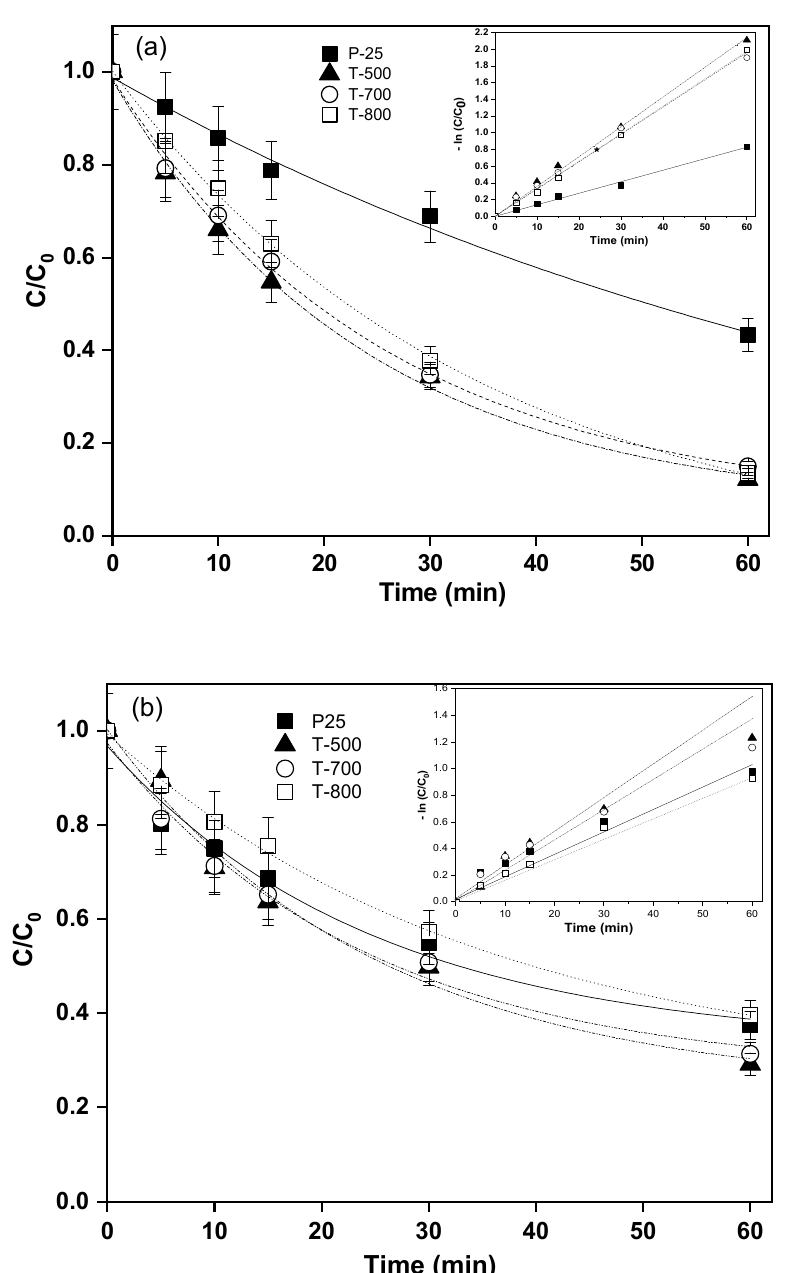
Figure 2. Change of the imazapyr ( a ) and phenol ( b ) concentration as a function of the illumination time using P-25, T-500, T-700, and T-800 photocatalysts. Insets are the linear fitting of the first order kinetics. Photocatalyst loading, 1 g L − 1 ; (O 2 saturated, pH = 3; T = 25 ± 1 °C); reaction volume 50 mL.